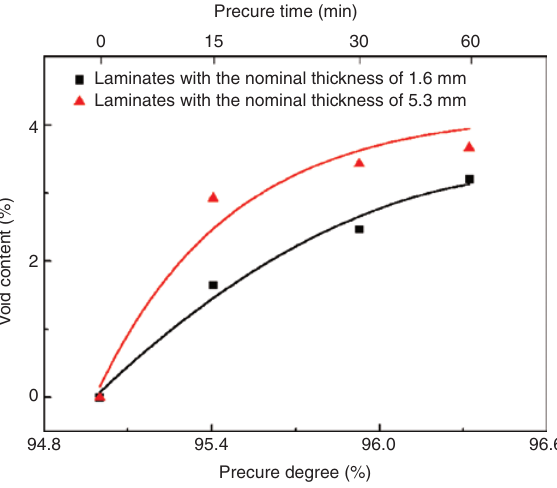
Figure 4: Relationship between void content and precure degree (or precure time at 80 ° C) of carbon/benzoxazine composite